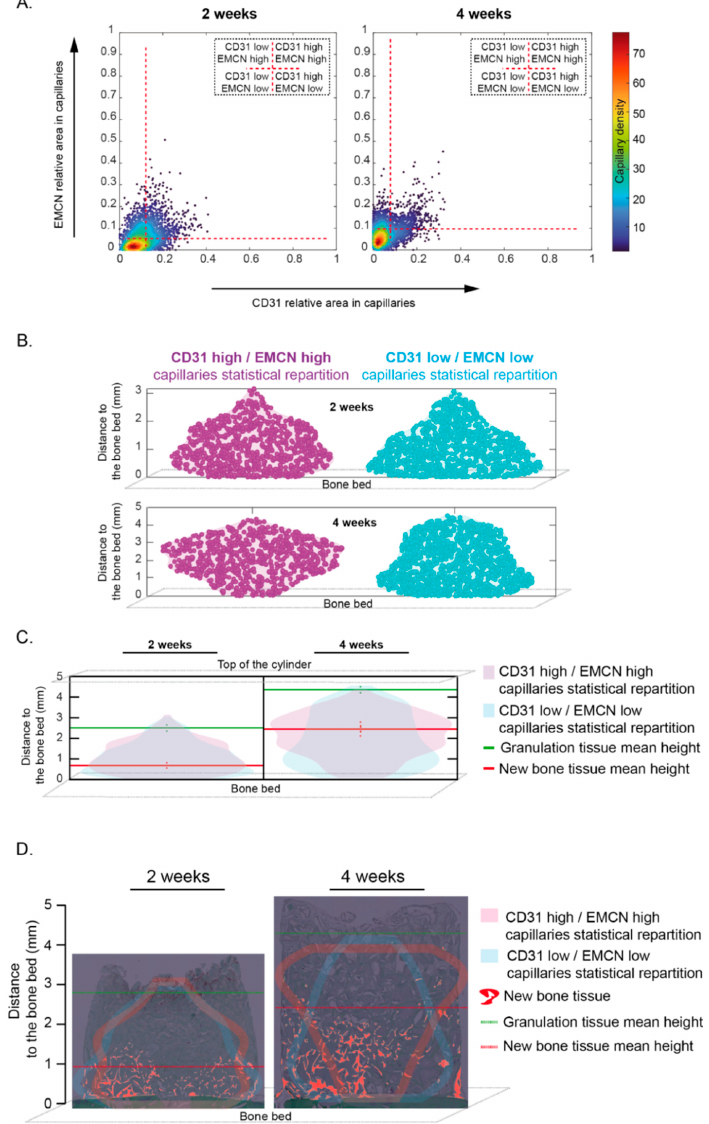
Figure 5. Capillaries subsets distribution within the cylinder contents at 2 and 4 weeks. ( A ) Scatter plots of EMCN vs. CD31 relative areas within capillaries for the whole samples at two weeks ( left , n = 6) and at four weeks ( right , n = 6). Each point is a color-coded capillary for its probability density of having such an EMCN and CD31 relative areas. Horizontal and vertical red dashed lines indicate, respectively, the EMCN and CD31 thresholds used to classify the capillaries in four categories. Thresholds were set in order to have most of the capillary density in the “CD31 Low/EMCN Low” category. ( B ) “Violin plots” representing the capillaries’ distribution within the whole cylinder content at two weeks (n = 6, top ) and four weeks (n = 6, bottom ). Purple and blue colors indicate, respectively, the “CD31 High/EMCN High”, and “CD31 Low/EMCN Low” capillaries and the horizontal spreading indicates the probability density of detecting capillaries at a given distance (smoothed by a kernel density estimator). ( C ) “Violin plots” representing the “CD31 High/EMCN High” (purple) and “CD31 Low/EMCN Low” (blue) capillaries distribution within the whole cylinder content, from the bone bed to the top of the cylinder, superimposed at 2 weeks ( left , n = 6) and 4 weeks ( Right , n = 6, top ). Granulation tissue (green) and new bone tissue (red) mean height +/ − sem (dotted vertical lines) were added. Note that the highest proportion of “CD31 High-EMCN High” capillaries was observed in-between the new bone tissue and the granulation tissue, namely within the